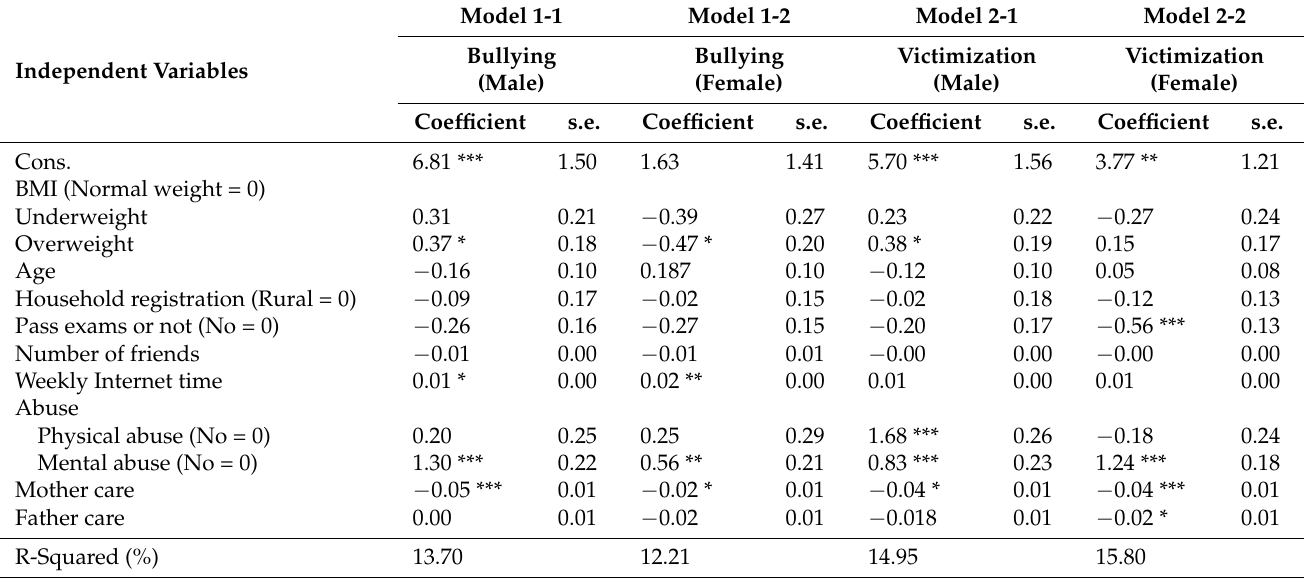
Table 2. Robust Regression Predicting Bully and Victim for Male ( n = 1456) and Female ( n =